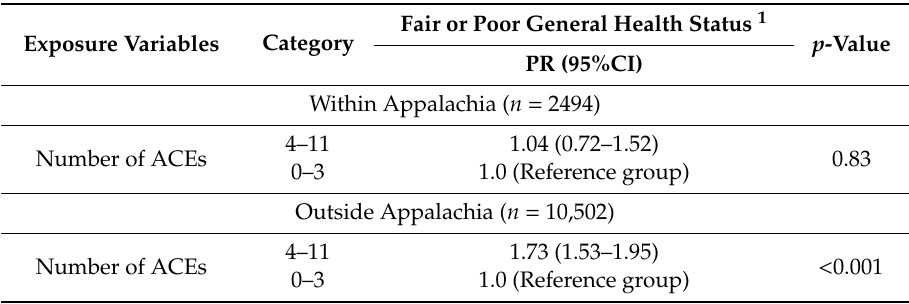
Table 3. Prevalence ratio (PR) of fair or poor health by Appalachian region, among North Carolina residents, 2012 &